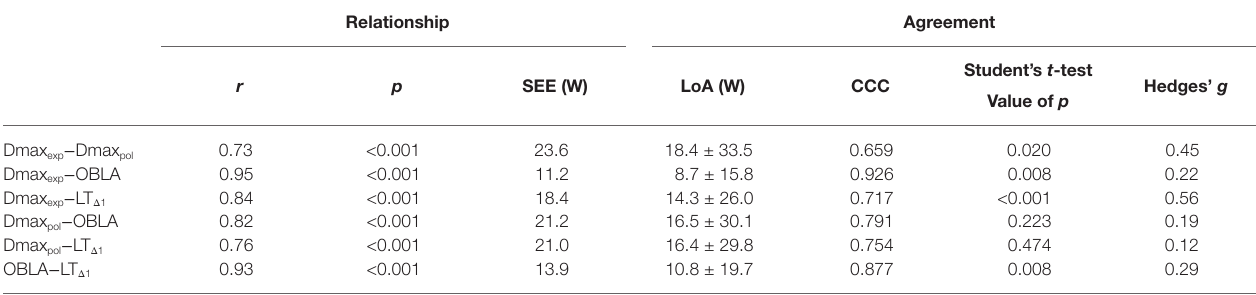
TABLE 1 | Relationship between the power output associated with different lactate threshold